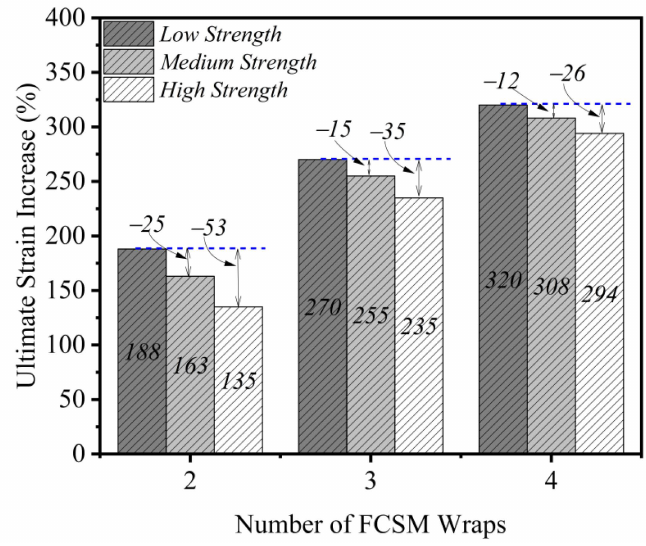
Figure 11. Effect of FCSM wraps and concrete strength on the increase in ultimate